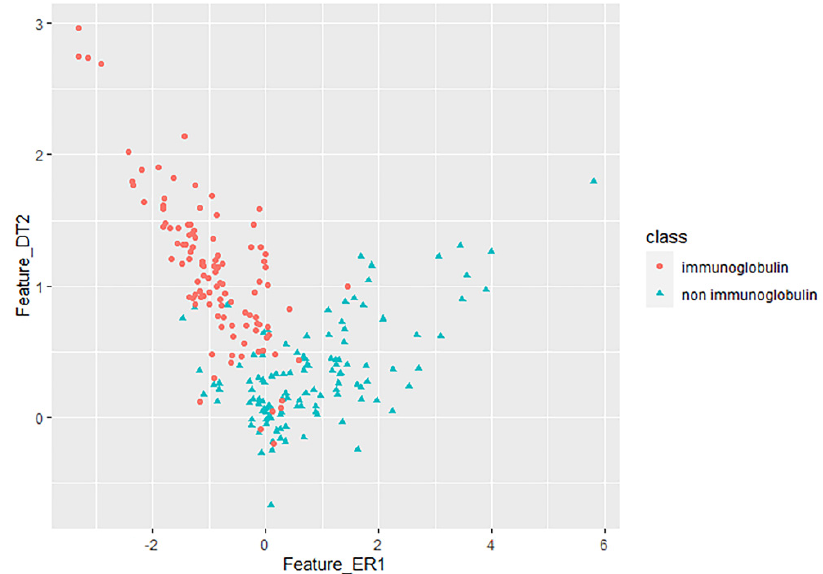
Figure 5. MRMD1.0+MRMD2.0 obtained key recognition and visualization results on the features extracted by CC–PSSM. CC (E, R, 1) and CC (D, T, 2) two–dimensional key feature prediction scatter plots of immunoglobulin.